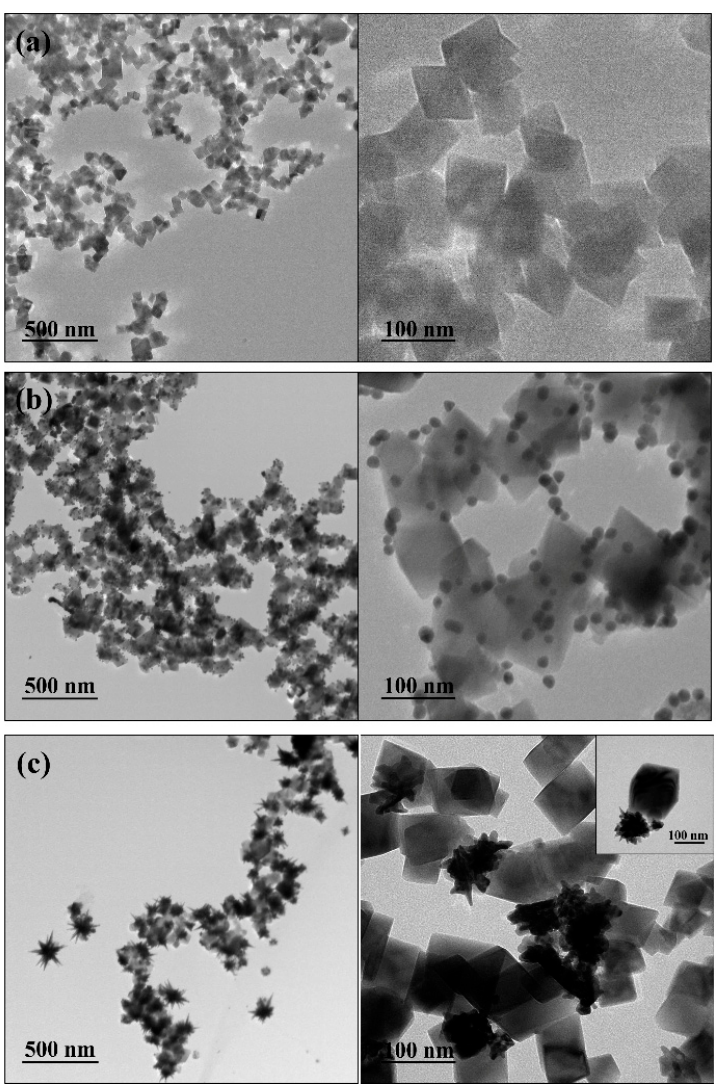
Figure 2. TEM images of ( a ) cubic Fe 3 O 4 NPs; ( b ) MNP-Au seeds; and ( c ) MNP-AuNS (inset shows a high-magnification image).